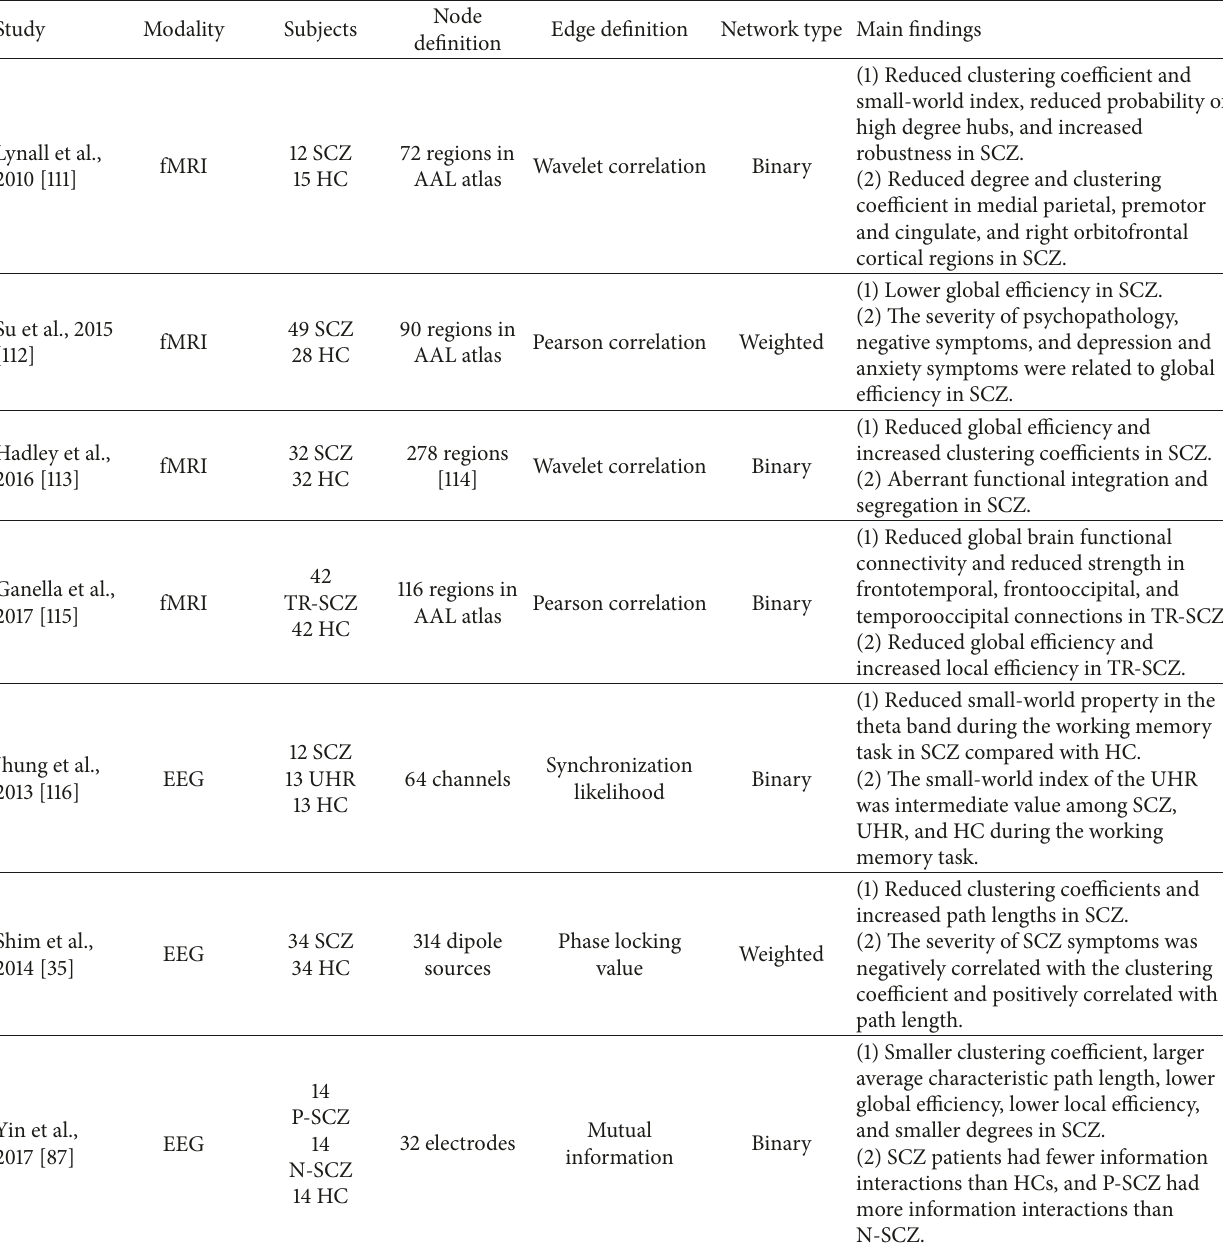
Table 5: Overview of functional brain network studies in